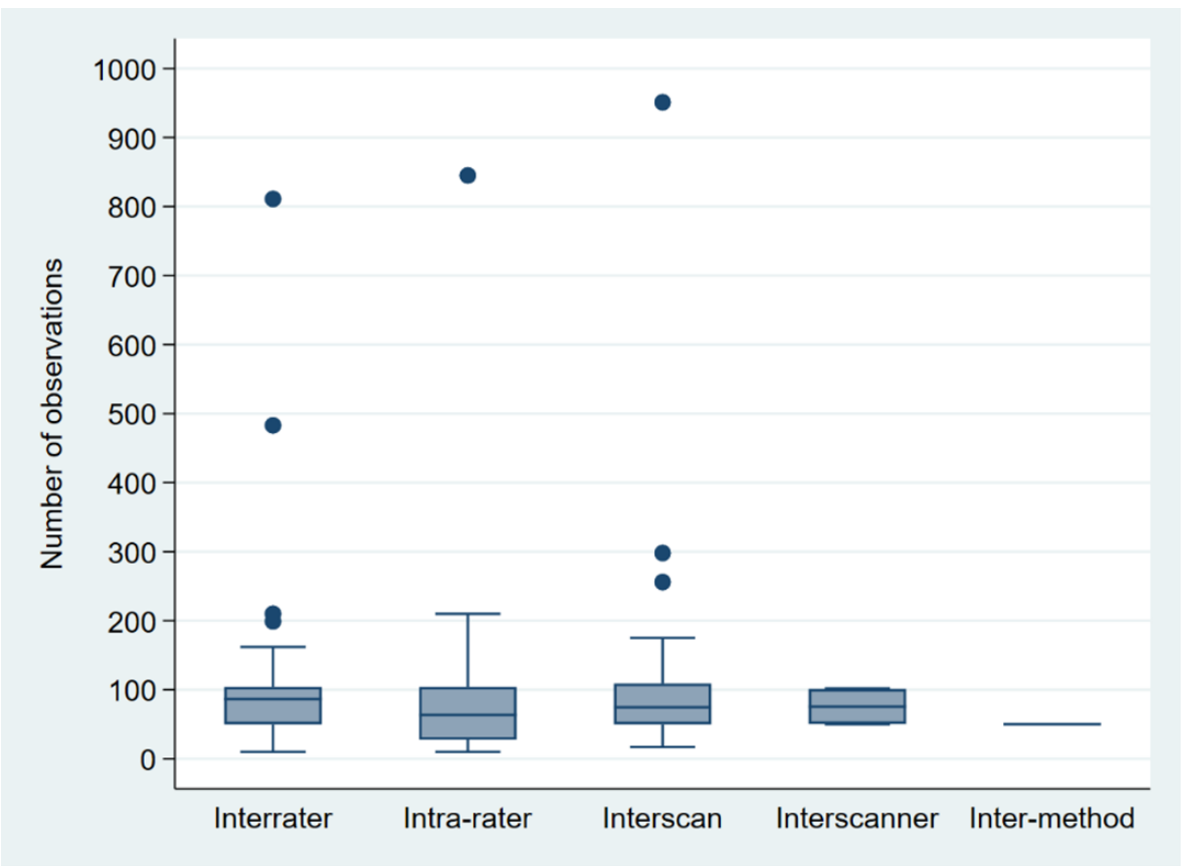
Figure 2. Boxplots for sample size by type of reproducibility assessment, excluding studies with more than 1000 observations [37,40,41,44,58] for better comparability.